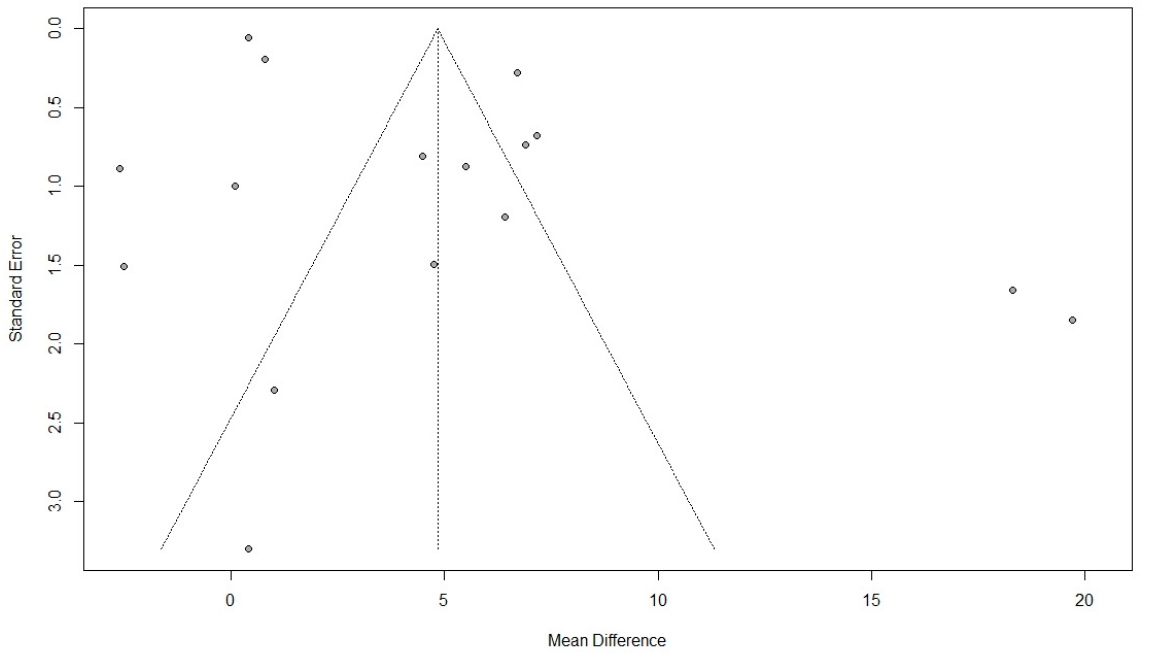
Figure 8. Funnel plot for the results of the effect of surgical intervention (vaginal and abdominal surgery) on total quality of sexual activity.